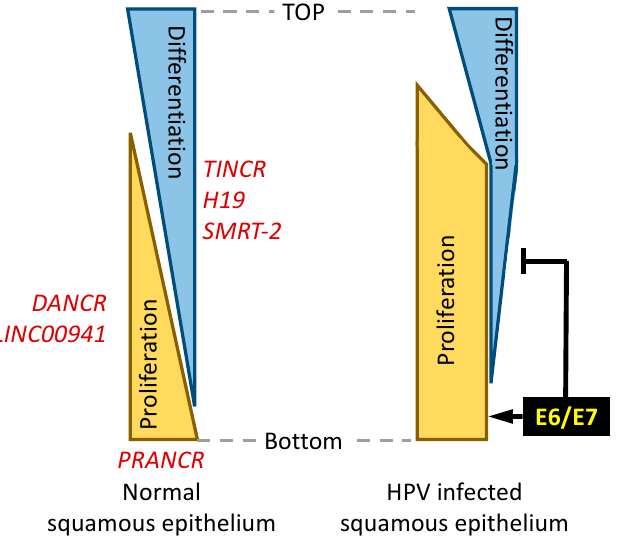
Figure 2. Proliferation and differentiation of normal ( left ) and HPV-infected ( right ) squamous epithelia. In normal squamous epithelia, the processes of proliferation and differentiation are coupled, whereas in HPV-infected epithelia, these processes are uncoupled due to HPV E6 and E7 expression. Consequently, there are an expansion of proliferating, poorly differentiated cells. LncRNAs (shown in red) that inhibit differentiation are shown on the left, while those that drive differentiation are shown on the right. PRANCR has been implicated as a regulator of differentiation and proliferation and is shown at the bottom. See text for details and references.